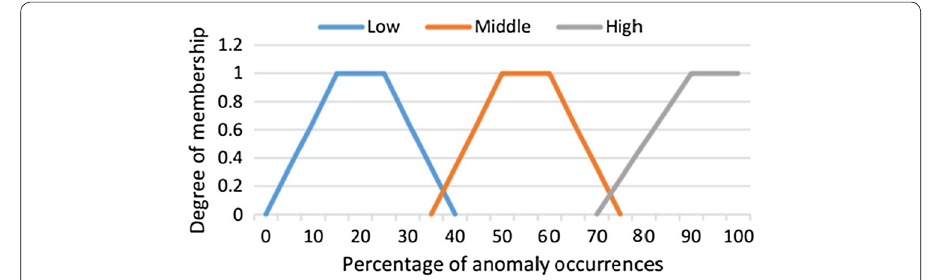
Fig. 4 Membership functions for percentage of anomaly